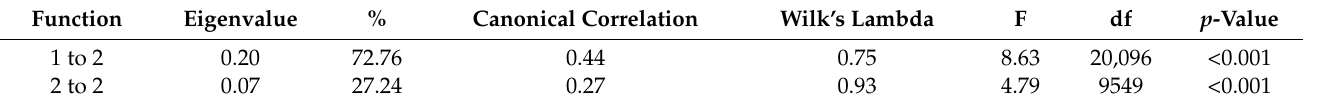
Table 5. Wilks’ Lambda, using F-approximation (Rao’s